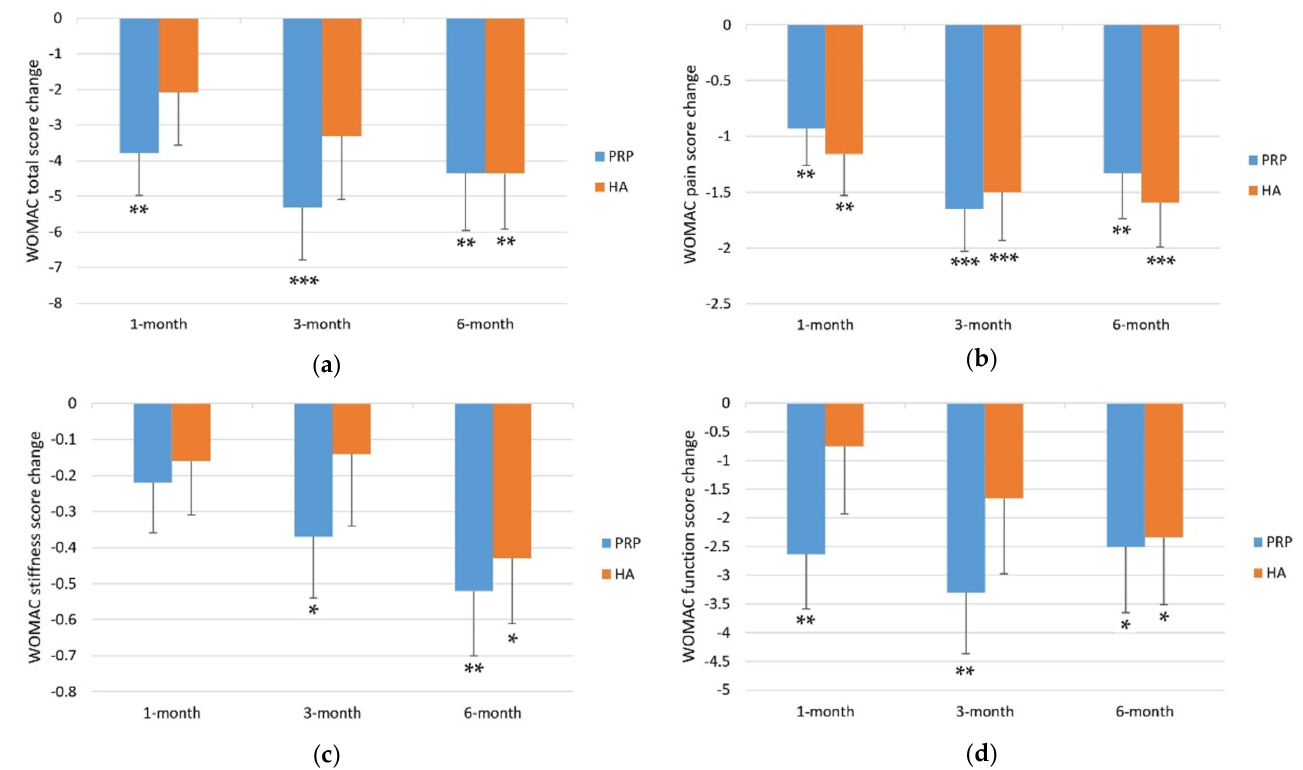
Figure 2. Mean changes in WOMAC scores from baseline to follow-up visits. ( a ) WOMAC total score change; ( b ) WOMAC pain score change; ( c ) WOMAC stiffness score change; ( d ) WOMAC function score change. Error bars indicate one standard error of the mean. Asterisks indicate p-values for the difference from baseline to follow up visits. * p -value < 0.05. ** p -value < 0.01. *** p -value <